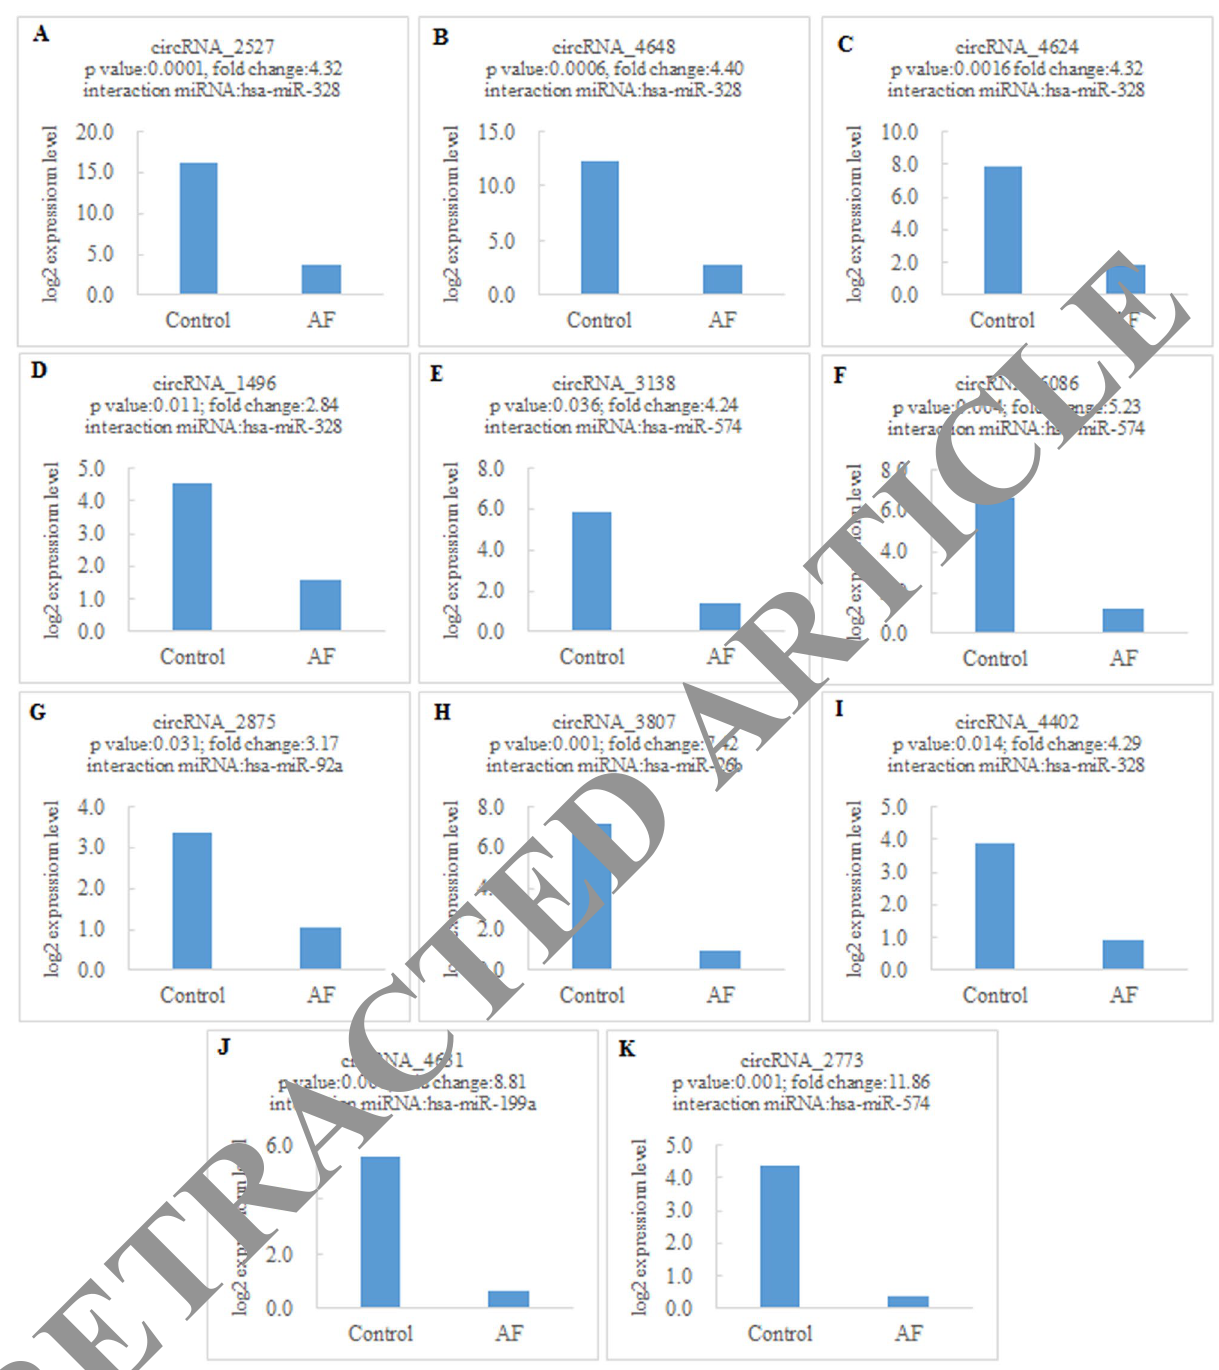
Figure 6. The expression pattern of the eleven down-regulated circRNAs that interact with atrial fibrillation related miRNAs. ( A ) The expression pattern of hsa_circRNA_2527 that interact with has-miR-328. ( B ) The expression pattern of hsa_circRNA_4648 that interact with has-miR-328. ( C ) The expression pattern of hsa_circRNA_4624 that interact with has-miR-328. ( D ) The expression pattern of hsa_circRNA_1496 that interact with has-miR-328. ( E ) The expression pattern of hsa_circRNA_3138 that interact with has-miR-574. ( F ) The expression pattern of hsa_circRNA_6086 that interact with has-miR-574. ( G ) The expression pattern of hsa_circRNA_2875 that interact with has-miR-92a. ( H ) The expression pattern of hsa_circRNA_3807 that interact with has-miR-26b. ( I ) The expression pattern of hsa_circRNA_4402 that interact with has-miR-328. ( J ) The expression pattern of hsa_circRNA_4631 that interact with has-miR-199a. ( K ) The expression pattern of hsa_circRNA_2773 that interact with